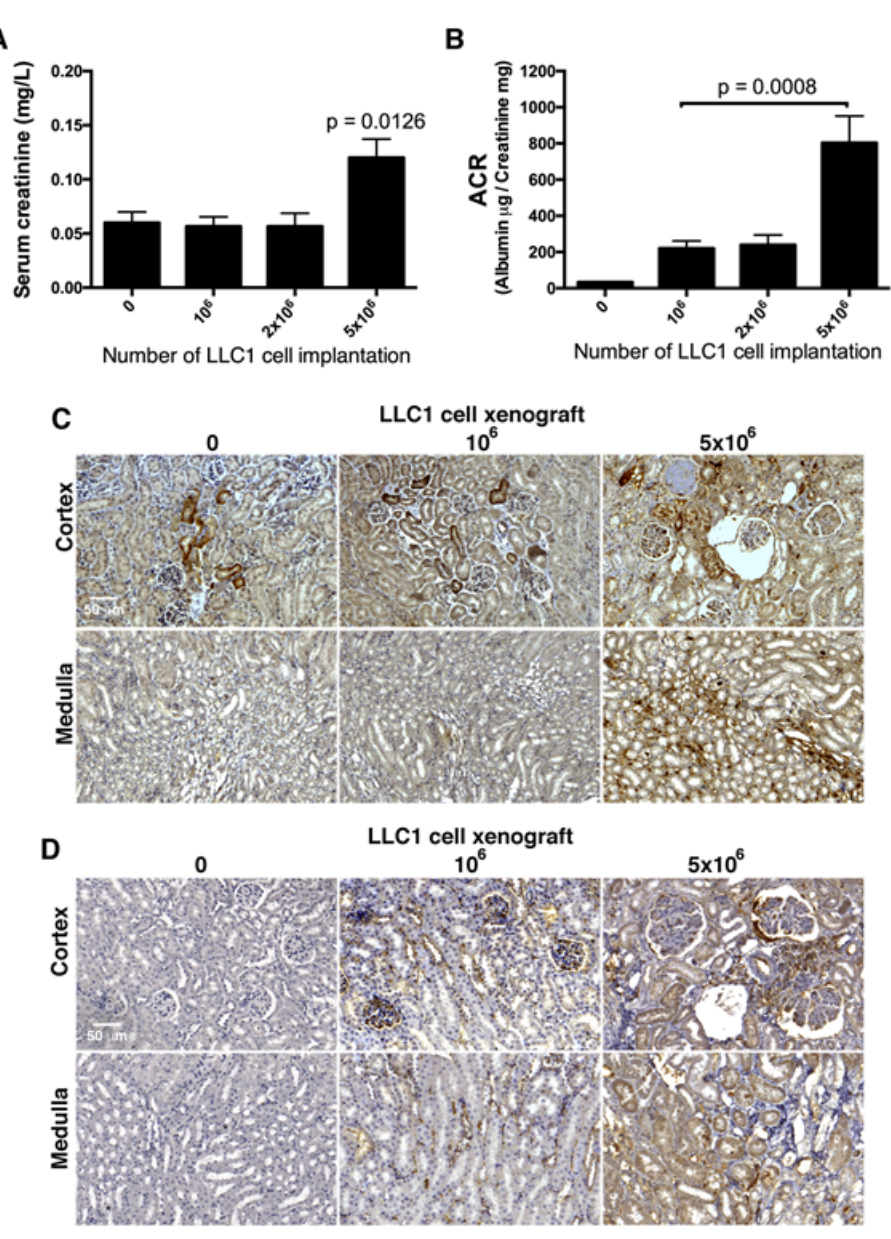
Figure 4. The number of LLC1 cells transplanted in the lungs was correlated with the severity of paraneoplastic inflammation in the kidneys. ( A ) Serum creatinine levels were not obviously increased in the mice with 1 × 10 6 and 2 × 10 6 LLC1 cells, and were slightly elevated in the mice with 5 × 10 6 LLC1 cells. ( B ) The urinary albumin to creatinine ratio (ACR) was slightly increased in the mice with 1 × 10 6 and 2 × 10 6 LLC1 cells, and robustly elevated in the mice with 5 × 10 6 LLC1 cells. ( C ) Renal inflammation was detected using immunohistochemical staining with specific antibody-recognized MCP-1. Relatively fewer renal tubules in the cortex and medulla had MCP-1 staining in the sham group, whereas more MCP-1 staining was seen in the renal tubules in the cortex, but not medulla in the mice with 1 × 10 6 LLC1 cells, and a large increase in MCP-1 staining was detected in the cortex and medulla in the mice with 5 × 10 6 LLC1 cells. ( D ) IL-6 as a proinflammatory cytokine was detected in the kidneys in both the lung cancer and sham mice. A few IL-6 signals were displayed in the kidneys of the sham mice, whereas IL-6 expression was relatively higher in the kidneys of the mice with 1 × 10 6 LLC1 cells, and IL-6 signals were strongly displayed in the kidneys of the mice with 5 × 10 6 LLC1 cells. Bar = 50 µ